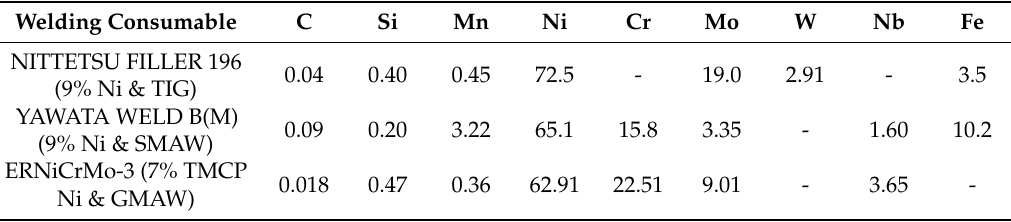
Table 7. Chemical composition of welding consumables for 9% and 7% TMCP nickel steels [5]. Welding Consumable